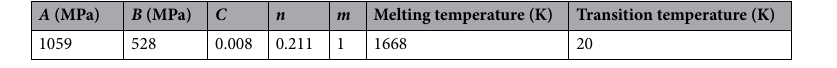
Table 4. Improved J–C model parameters of 42CrMo steel.